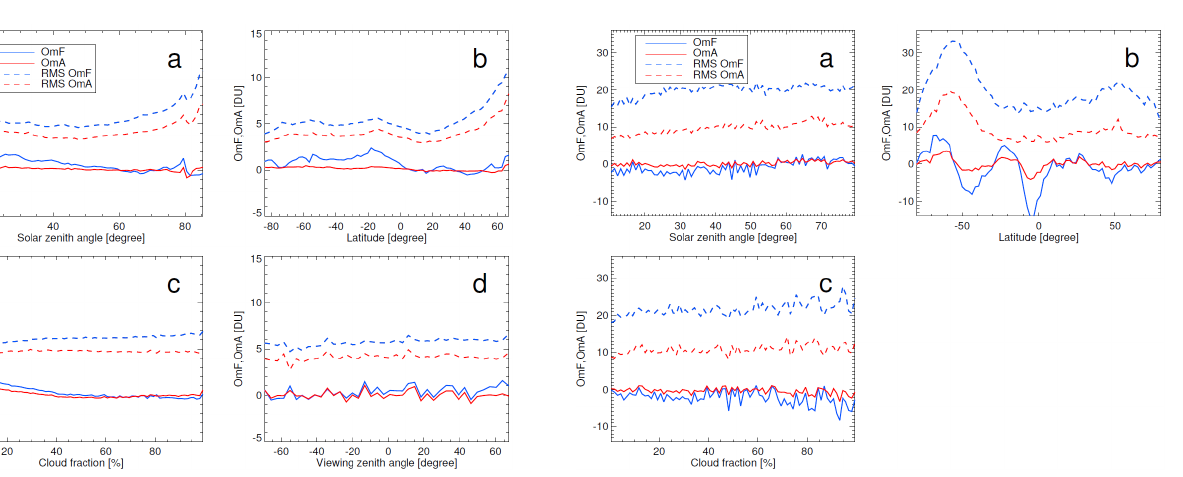
Figure 7. Same as Fig. 6, but no panel (d) . There is no change in viewing angles in this period, because BUV has only nadir observa- tions. All data are averaged over